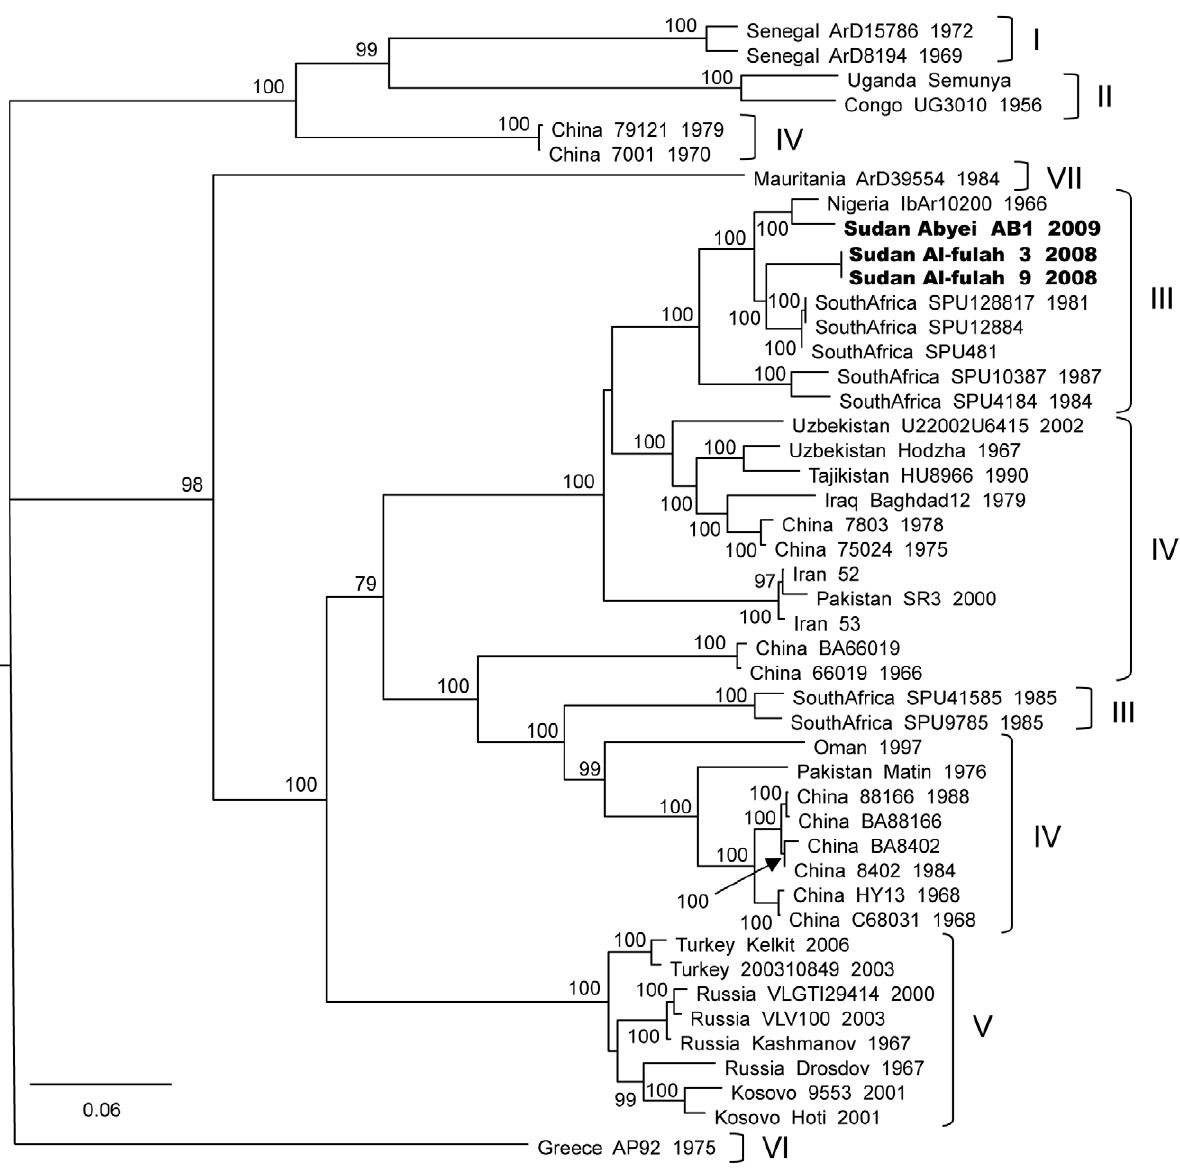
Figure 3. Phylogenetic relationship of Crimean-Congo hemorrhagic fever virus full length M segments. Phylogenetic relationship of the M segment sequence of the CCHF virus Abyei and Al-fulah strains relative to previously published sequences was carried out using GARLI (v0.96b8) [18], with default settings to generate a maximum likelihood tree with bootstrap support values from 1000 replicates. The 50% majority rule tree is depicted. Each strain is listed by its location, strain name, and year of isolation when available with the Sudanese strains